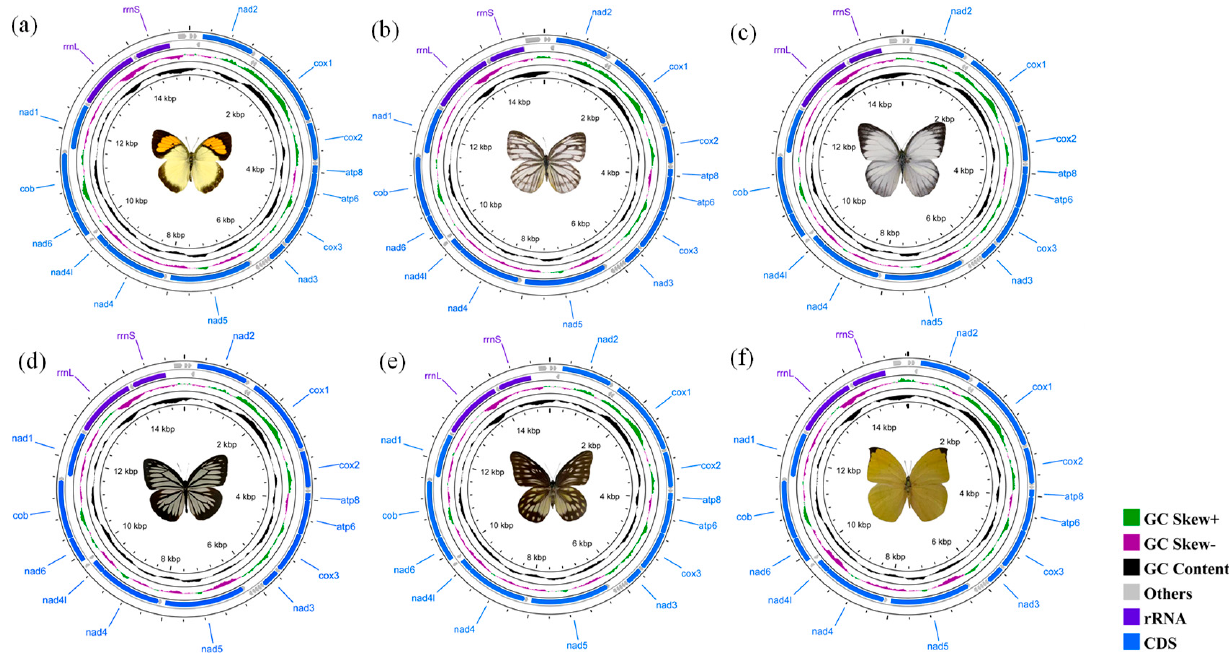
Figure 1. The circle maps of the complete mitochondrial genomes of ( a ) I. pyrene , 15,178 bp, ( b ) C. nerissa, 15,185 bp, ( c ) C. nadina , 15,216 bp, ( d ) P. anais, 15,161 bp, ( e ) Pr. thestylis , 15,174 bp, and ( f ) D. lycorias, 15,242 bp. In total, thirteen PCGs and two rRNAs were considered; the arrow indicates the direction of the gene from start to end.